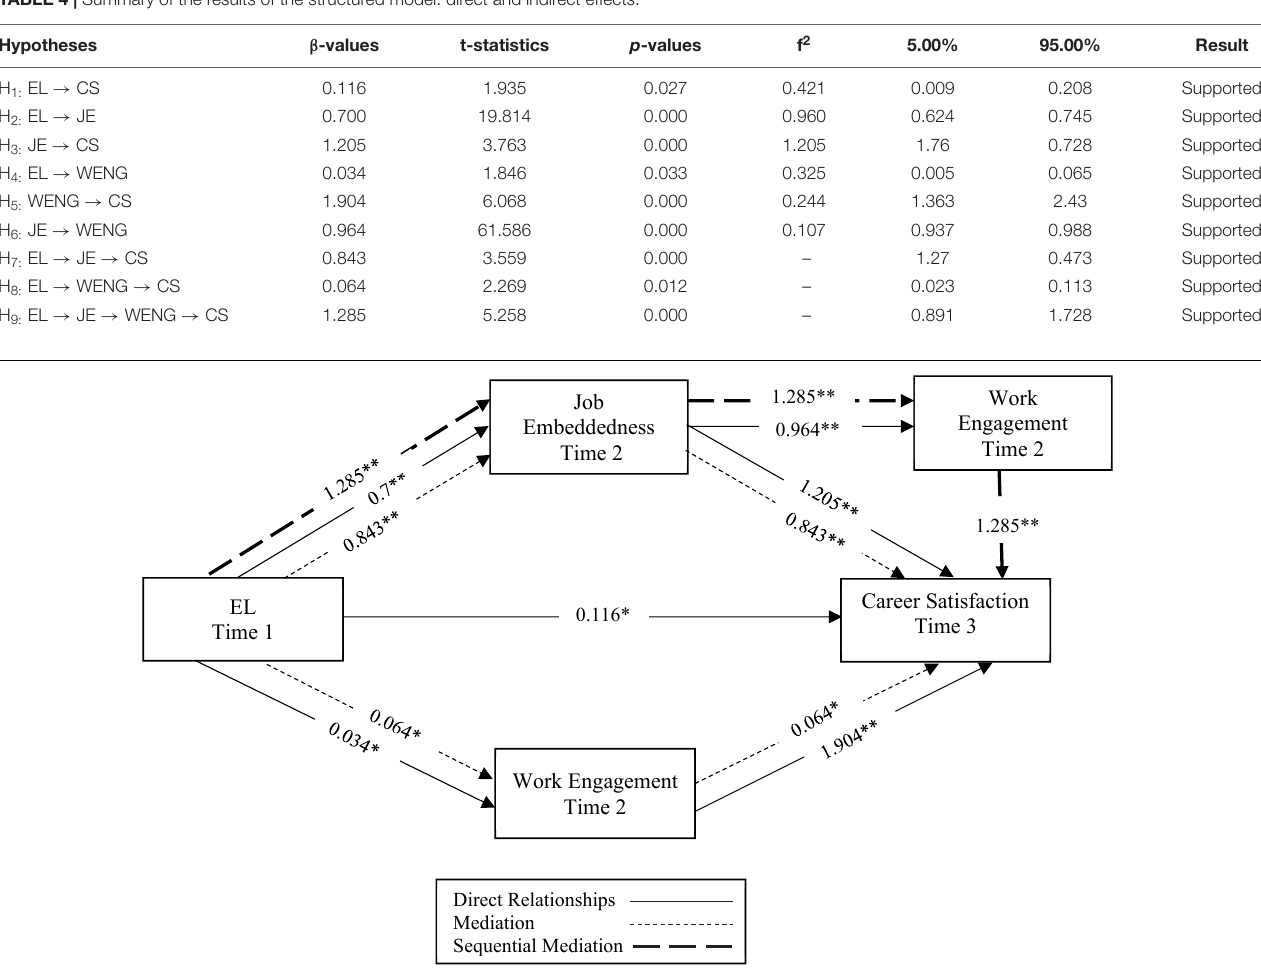
FIGURE 2 | Summary of results of the structural model with direct paths, mediation, and sequential mediation effects. *Correlation is significant at 0.05 (2-tailed), **Correlation is significant at 0.01